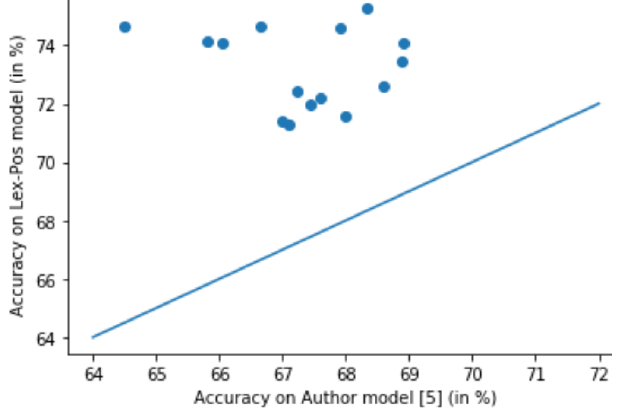
Figure 1. Accuracy values on 15